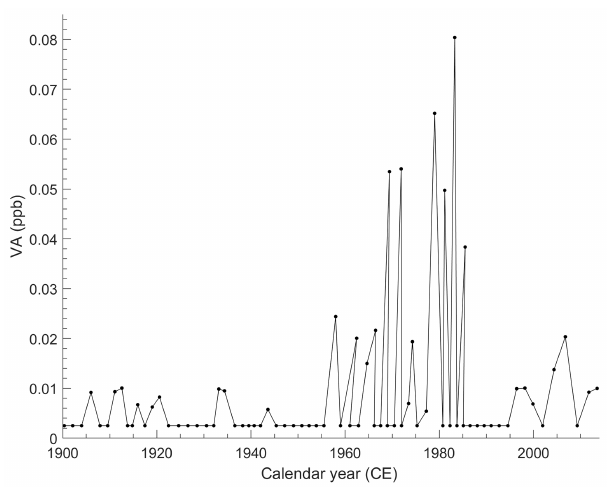
Figure 4. The 20th century Tunu ice core VA